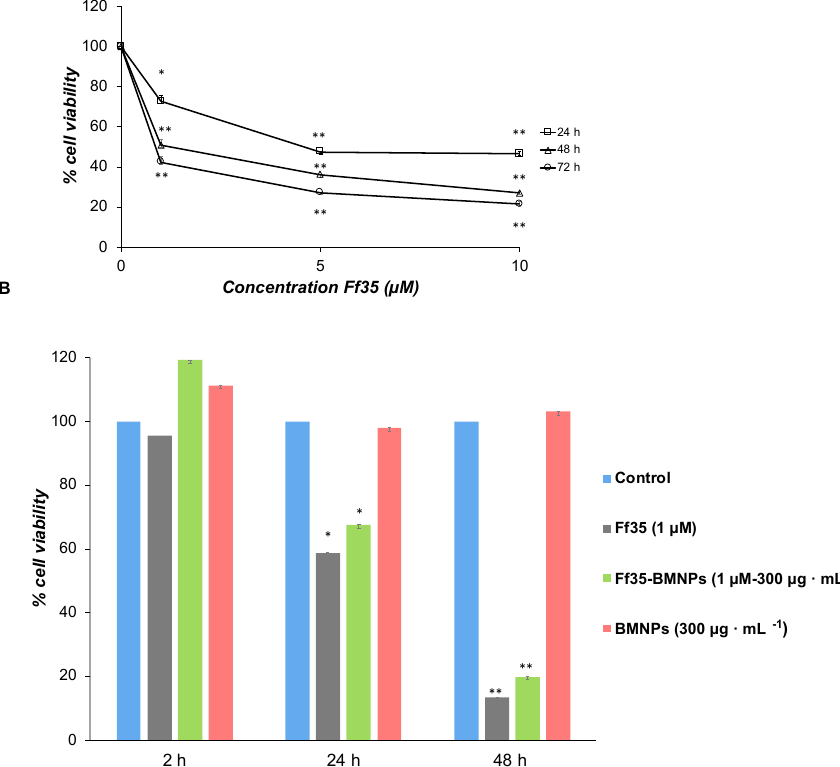
Figure 4. Effects of Ff35, BMNPs, and Ff35-BMNPs on HepG2 cell proliferation. HepG2 cells growing in the log phase were incubated with Minimum Essential Medium containing 10% heat-inactivated fetal bovine serum (MEM/10% FBS) in the presence or absence of Ff35 up to 10 μ M ( A ) or Ff35 1 μ M, BMNPs 300 μ g mL − 1 or Ff35-BMNPs (concentration of Ff35 was 1 μ M and that of BMNPs was 300 μ g mL − 1 ) ( B ). Cell viability was determined by MTT assay and normalized to that of the respective control cells. These experiments were performed twice in triplicate. * p < 0.05, ** p < 0.001 compared to their respective controls.